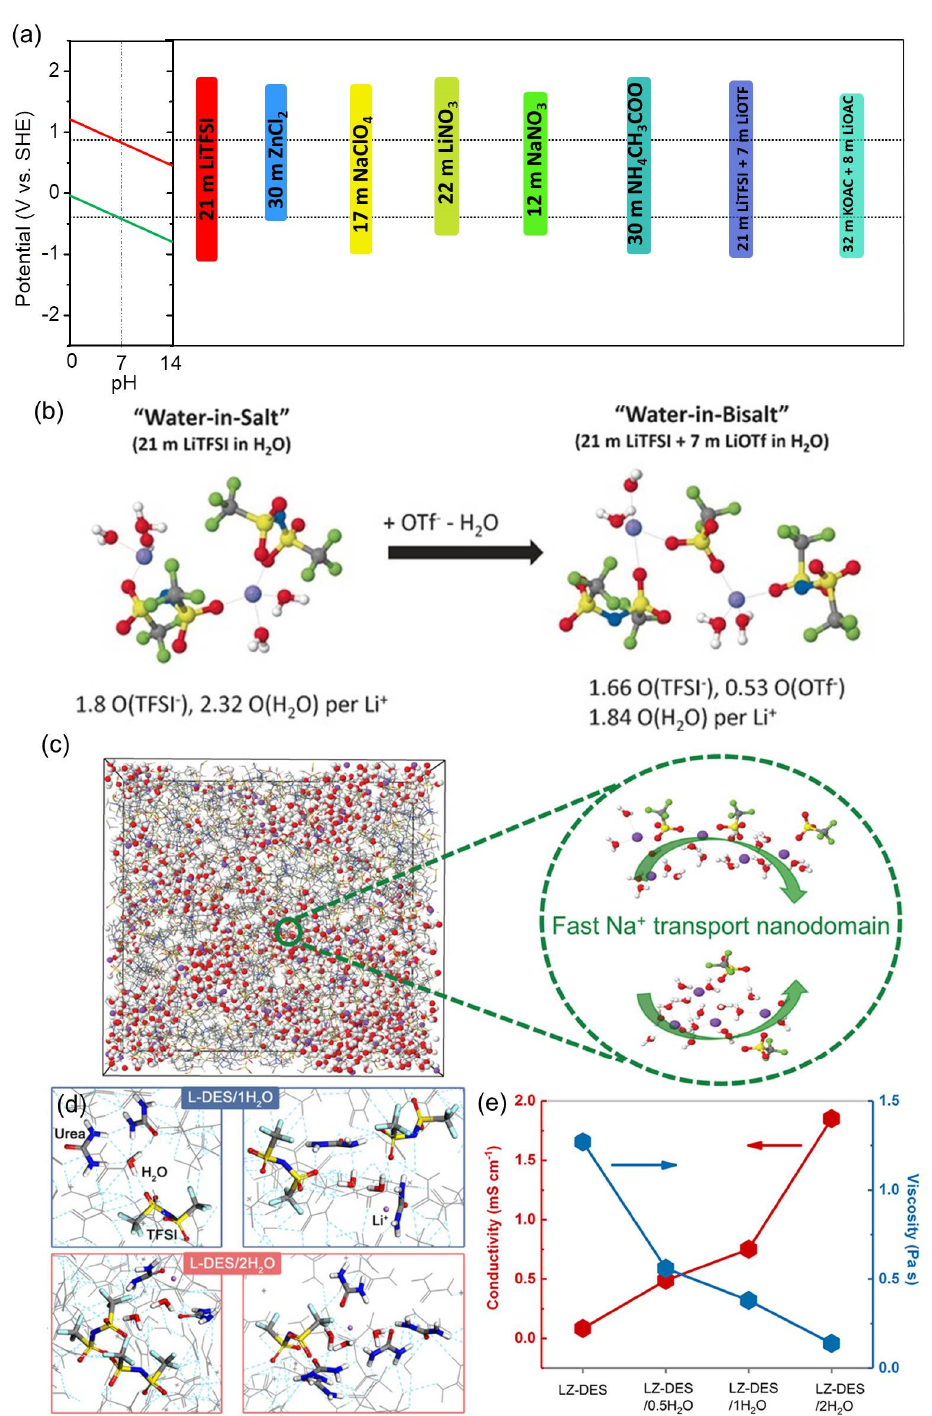
Figure 5. ( a ) Plot showing the ESW of various WIS electrolyte systems. Schematic representations indicating the intermolecular interactions of ( b ) LiTFSI/LiOTf [101] and ( c ) NaOTf/TEAOTf-based WIS electrolytes [102]. ( d ) Diagrams of equilibrated Li-based DES electrolyte, and ( e ) plot of ionic conductivity and viscosity changes in Li/Zn DES electrolyte upon addition of various amounts of water [106].